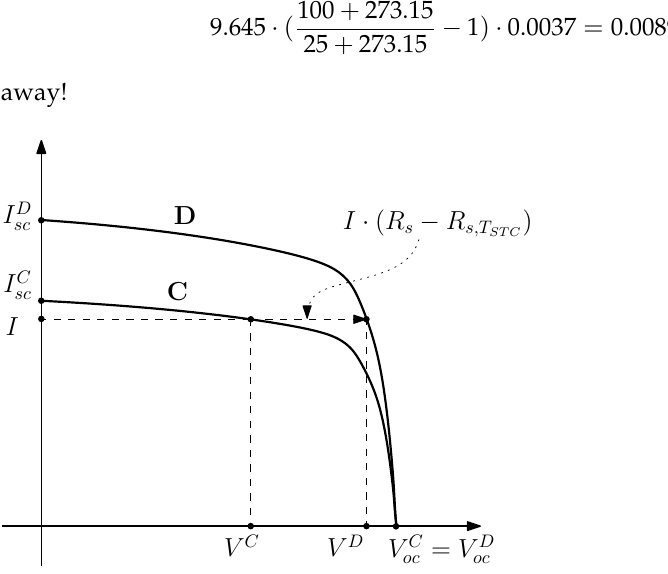
Figure 6. A sketch of two I – V curves C , D in the single-diode model for series resistors R s > R s , T respectively, and identical parameters